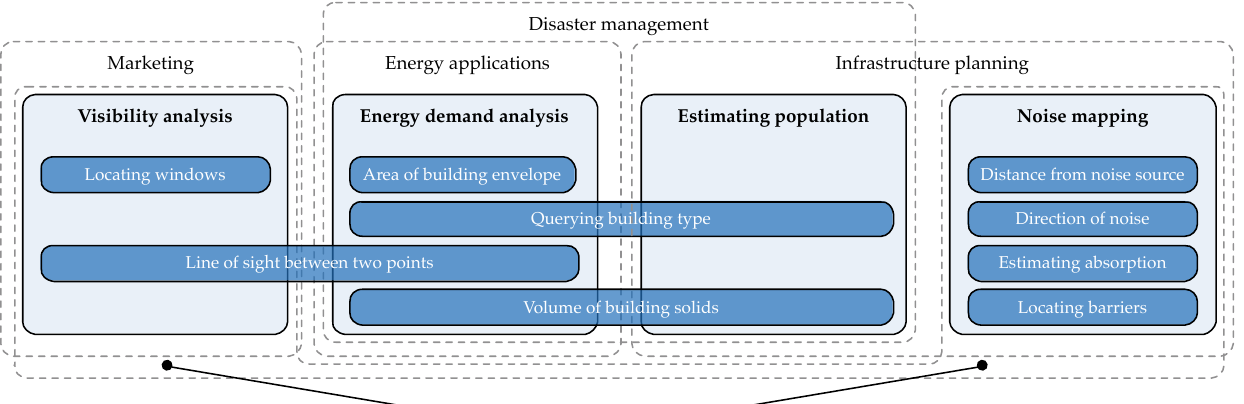
Figure 2. The tangled relations between spatial operations (dark blue), use cases (light blue) and applications (outlined with a dashed stroke), and their overlap which